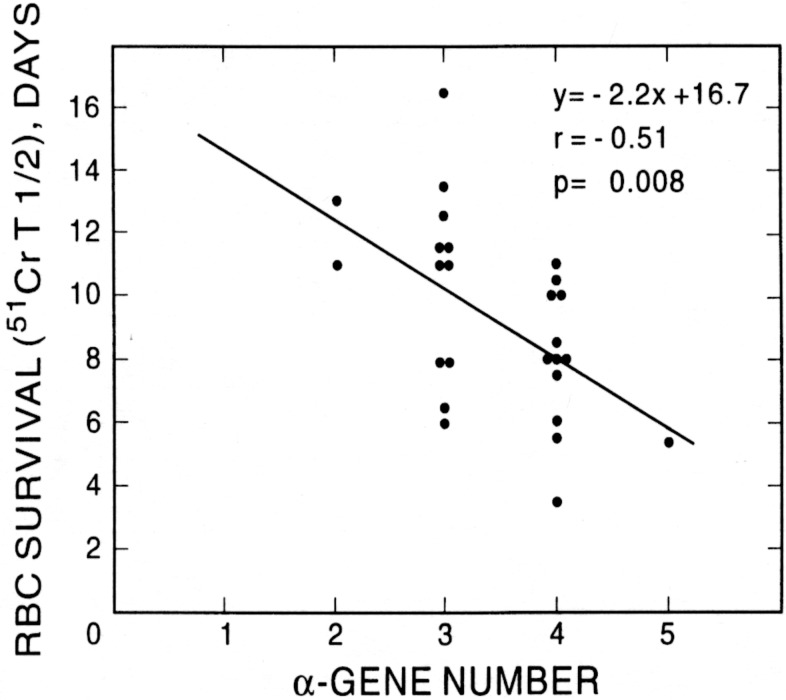
Effect of α genotypes on RBC survival in patients with sickle cell anemia in the steady state.From Ballas and Marcolina, Hemoglobin 24:277, 2000 with permission.